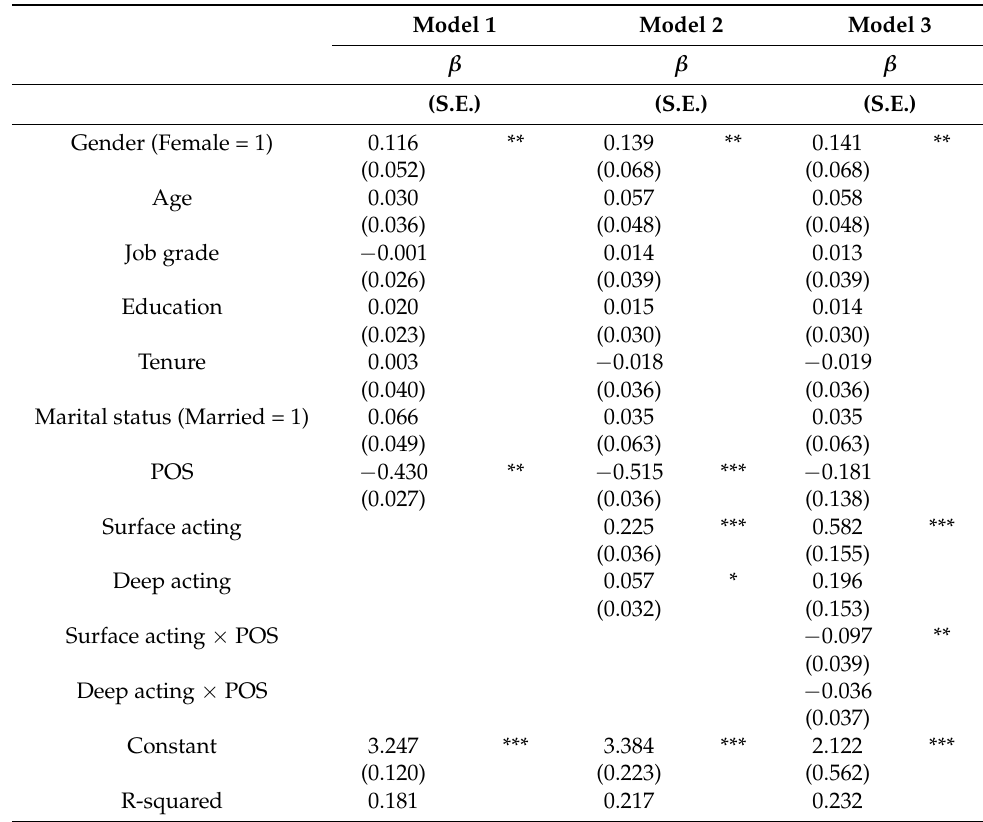
Table 3. OLS regression results for the hypothesized